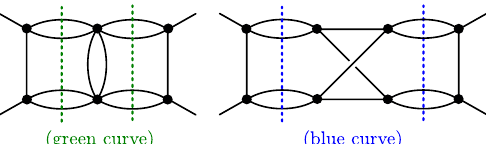
Figure 9: Slicing of multi-particle graphs with 2-particle cuts where each cut bubble corresponds to a particle of mass 2 m . equation (18) may be used to find the Landau curves represented by these diagrams. Green is given by equation (19) and blue follows from eqs. (20) and (21).